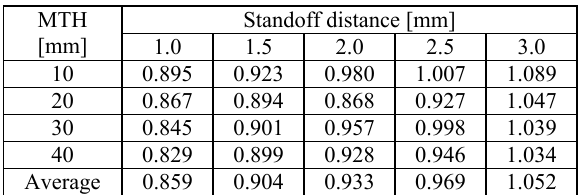
Table 1. KW values on top region, w s [mm] [11]